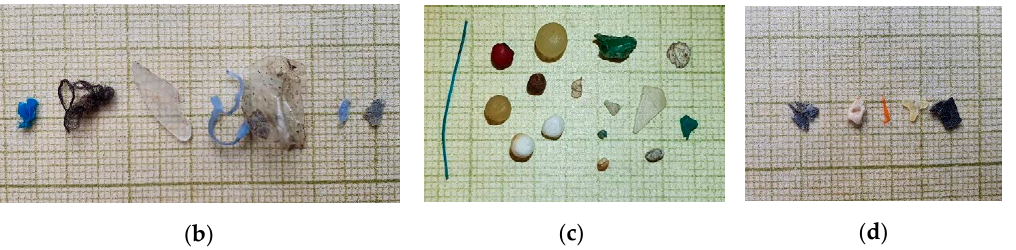
Figure 3. Examples of marine plastic litter collected at: ( a ) beach and coastal seawater on Crete; ( b ) marine sediment in the Eurasian Arctic Ocean; ( c ) Oslofjord beaches; ( d ) sea surface water in the Eurasian Arctic Ocean.